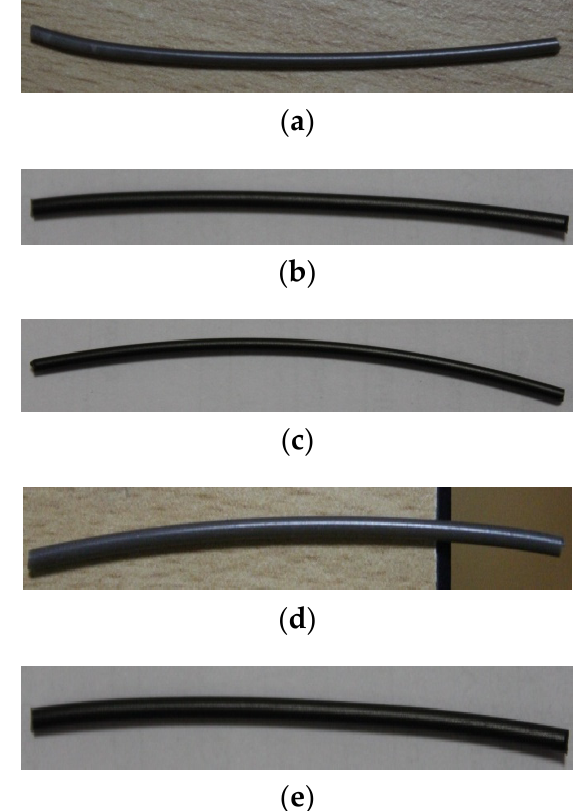
Figure 3. Photograph of filaments with incremental filler content. ( a ) PC-ABS. ( b ) PC-ABS + 0.2 wt % graphene. ( c ) PC-ABS + 0.4 wt % graphene. ( d ) PC-ABS + 0.6 wt % graphene. ( e ) PC-ABS + 0.8 wt % graphene.